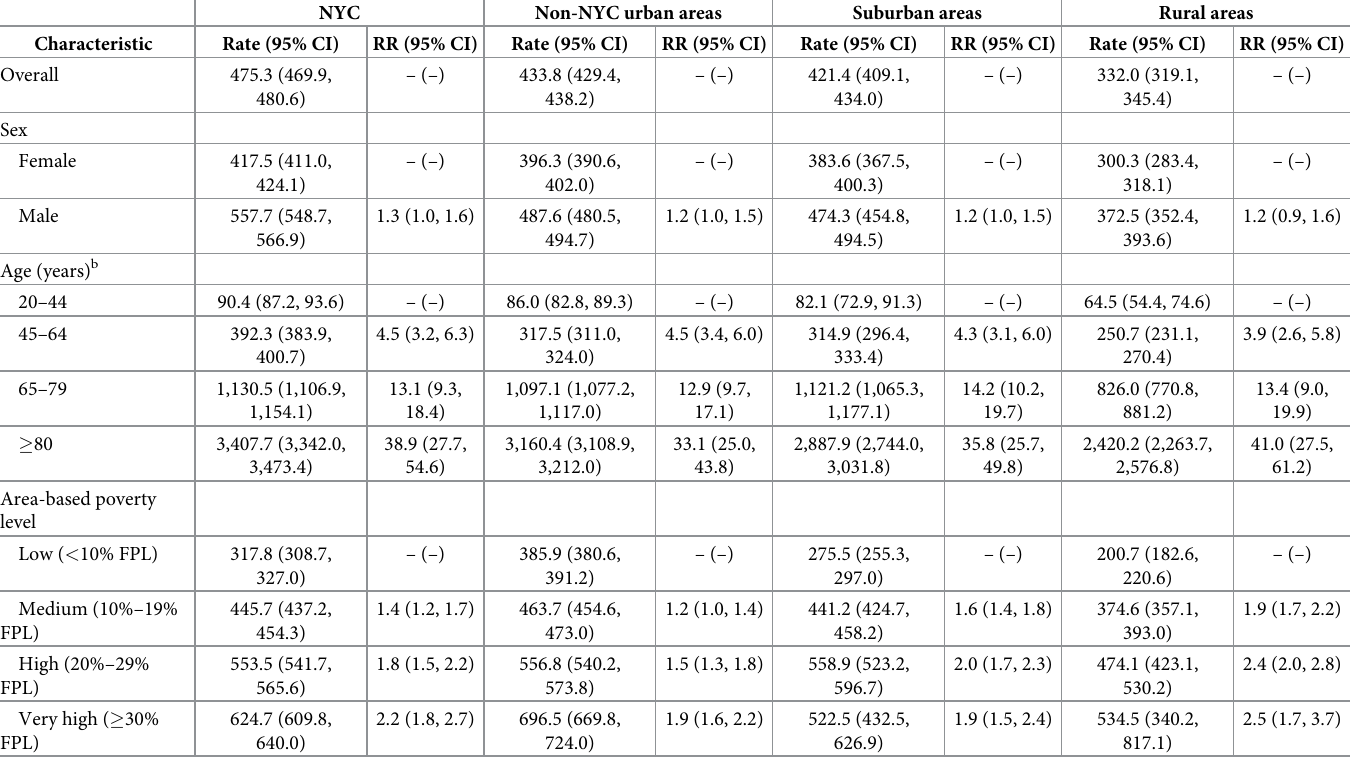
Table 2. Mean annual age-adjusted community-setting pneumonia-associated hospitalization rates in New York City, non-New York City urban areas, suburban areas, and rural areas—New York State, 2010–2014 a